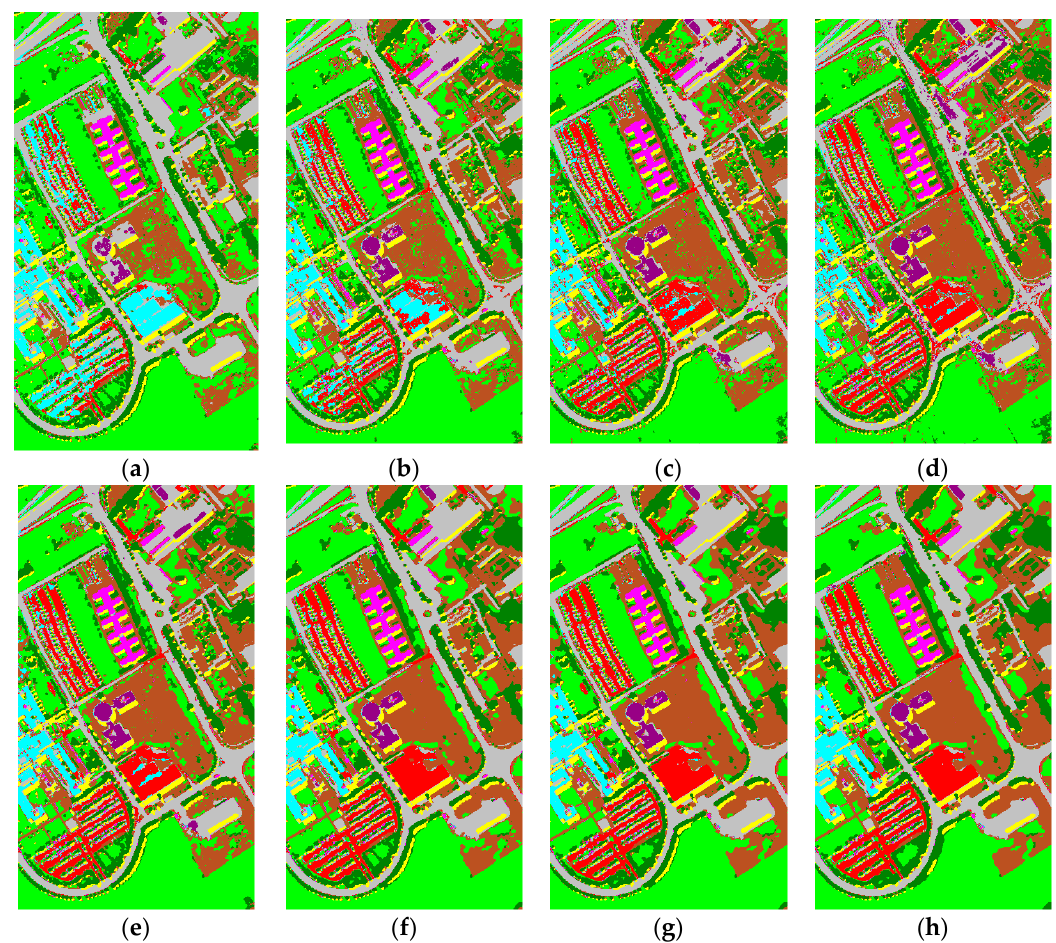
Figure 10. Classification maps for the University of Pavia data set by the CS-GC method using different parameter settings: ( a )